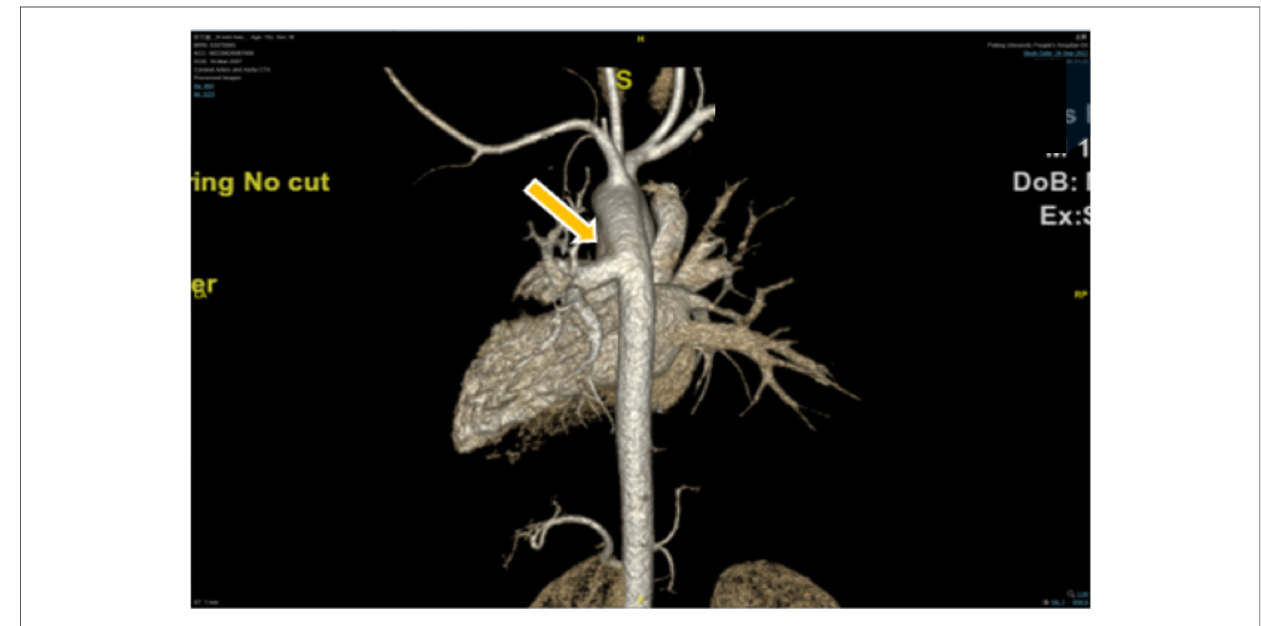
FIGURE 1 Preoperative three-dimensional angiography. Anomalous origin of the left pulmonary artery from descending aorta is indicated by the yellow arrow.